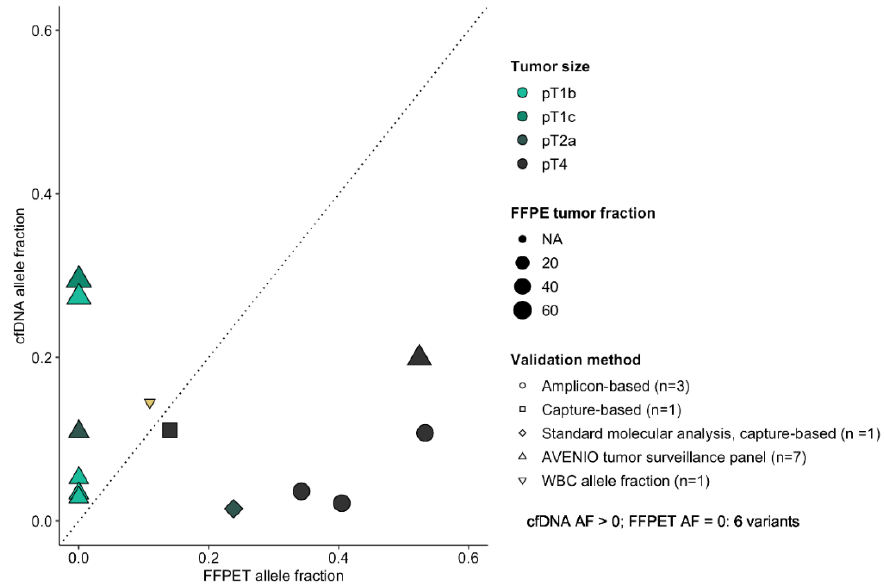
Figure 4. Tumor histology, tumor heterogeneity, and a low circulating tumor DNA fraction probably play a role in the discordance between cell-free DNA and tissue results. This plot represents the validation data on formalin-fixed, paraffin-embedded tumor (FFPET) tissue for 12 cell-free DNA (cfDNA) variants. The cfDNA variant allele fractions are plotted against the FFPET variant allele fractions. Symbols indicate the used validation method, whereby the size and color of the symbols annotate tumor cell percentage (FFPE tumor percentage, determined on a hematoxylin-eosin stained FFPE section) and size, respectively. For each method, the number of analyzed variants is given. Six cfDNA variants were not present in the FFPET sample. NA: not available.